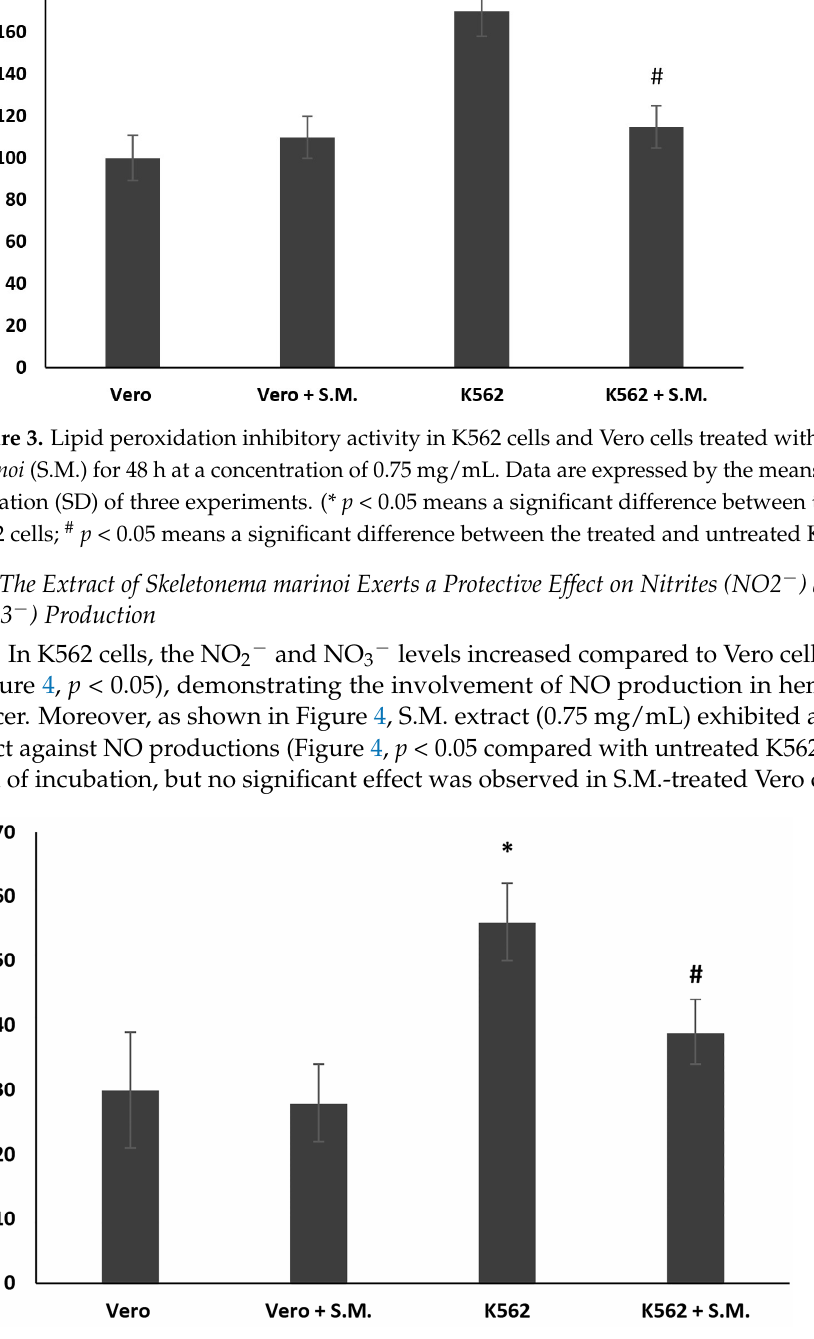
Figure 4. Effect of Skeletonema marinoi (S.M.) on nitric oxide (NO) production in K562 and Vero cells. After 48 h of treatment with 0.75 mg/mL of S.M., nitrites (NO 2 − ) and nitrates (NO 3 − ) levels were assayed by the Griess reagent. Data were represented by the means ± standard deviation (SD) of three experiments. (* p < 0.05 means a significant difference between the Vero and K562 cells; # p < 0.05 means a significant difference between the treated and untreated K562 cells).